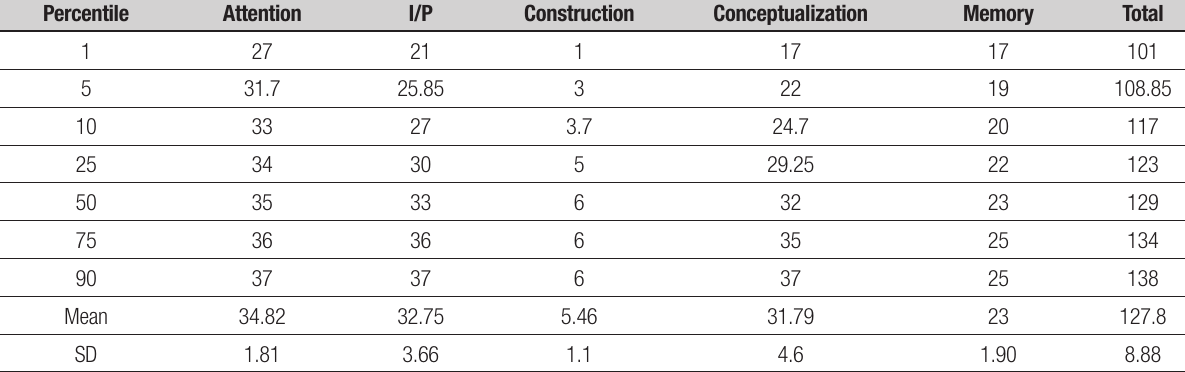
Table 5. Percentiles for subjects with 1-4 years of schooling and 71 to 80 years of age ( n=107). Percentile